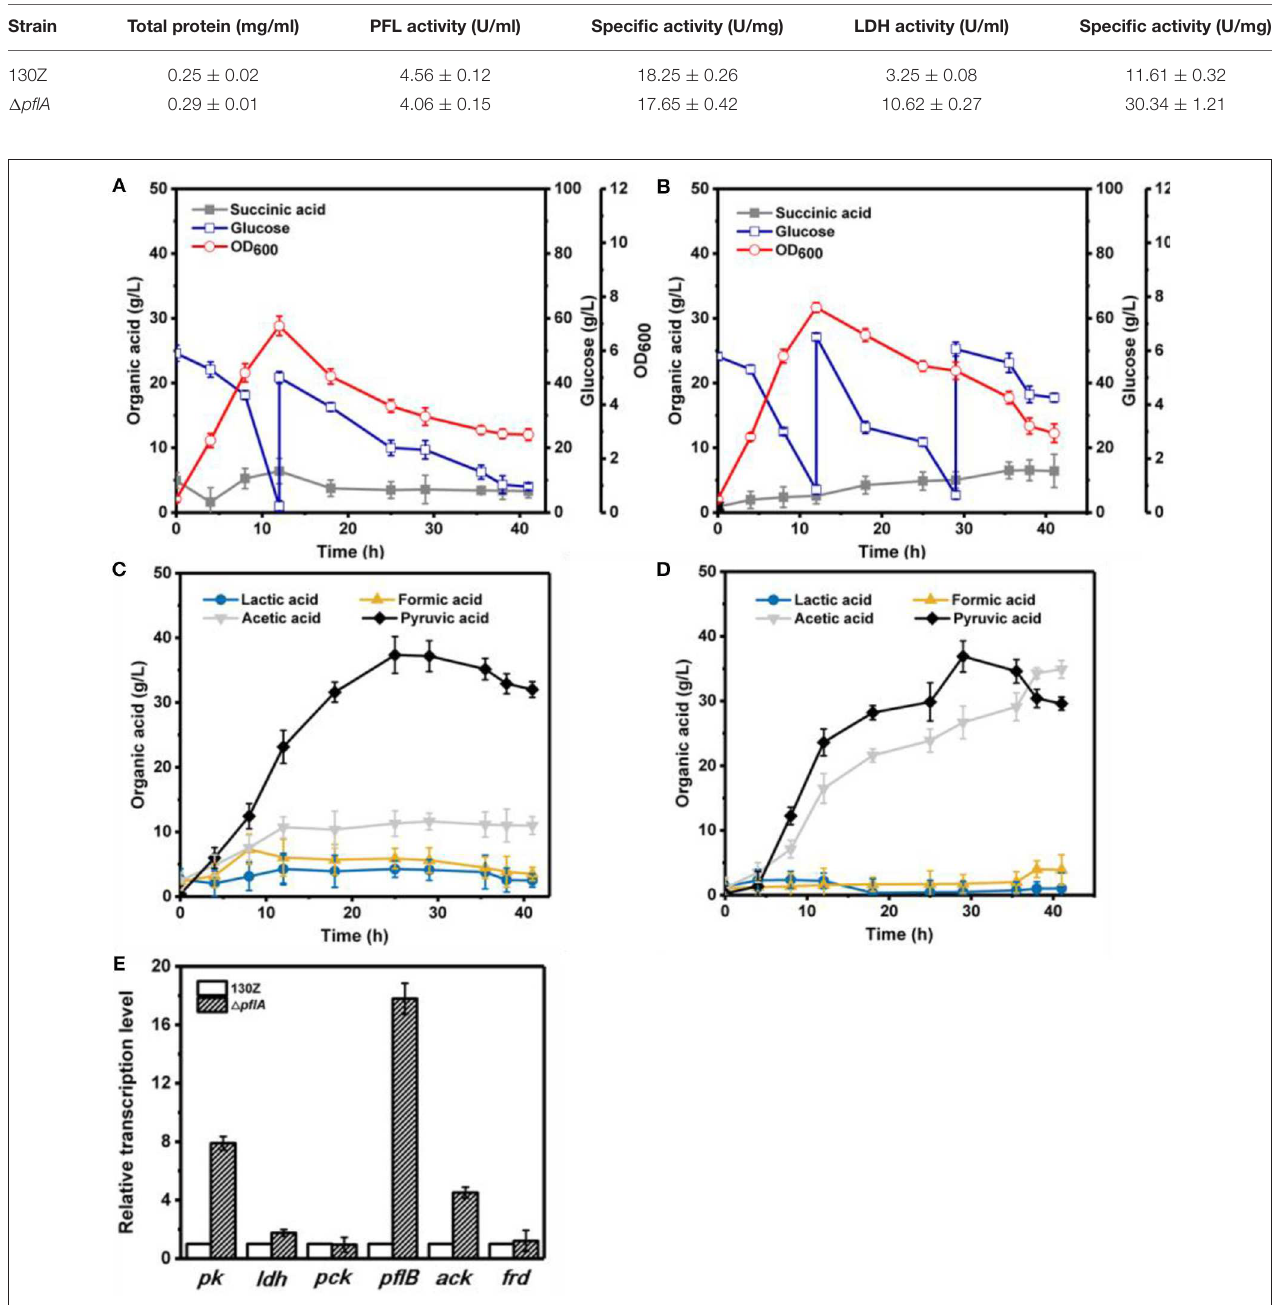
FIGURE 4 | Evaluation of different fermentation and metabolic parameters in the 130Z strain (A,C) compared to those of the 1 pflA strain (B,D) under aerobic conditions. The bar graph (E) represents the expression levels of genes related to organic acid biosynthesis pathway.